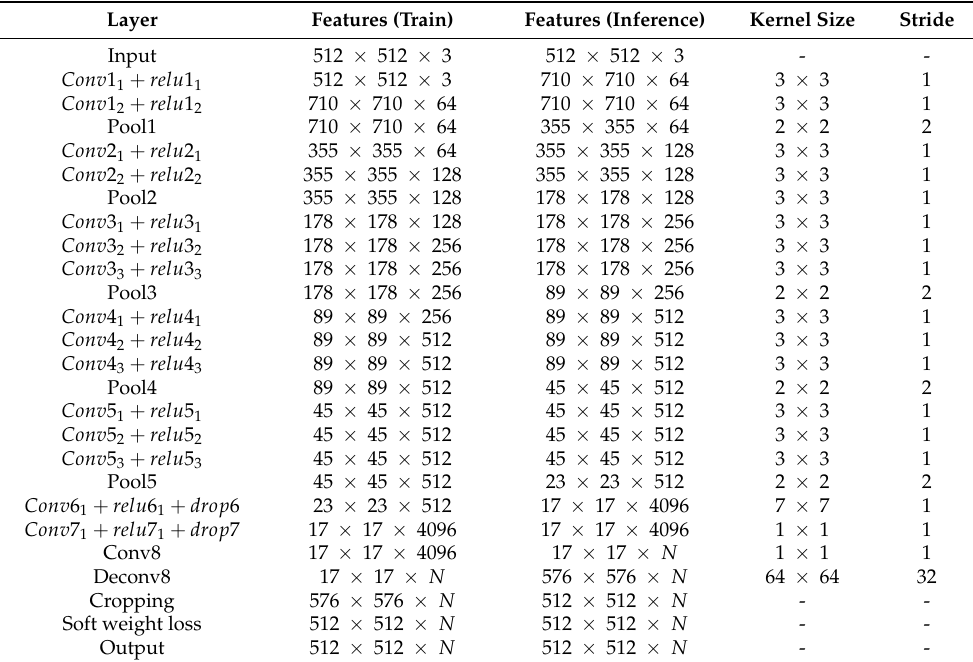
Table 2. The structure of the proposed soft label FCN. Layer Features (Train) Features